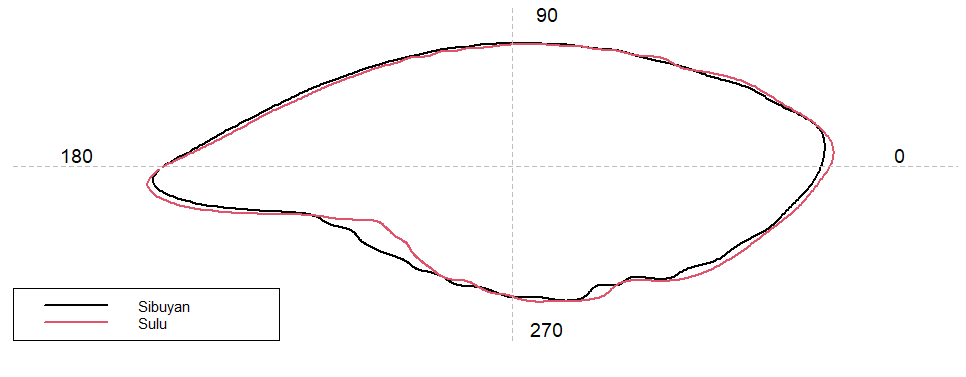
Figure 6. Mean right otolith shapes of D. kurroides collected from the Sibuyan Sea and Sulu Sea, Philippines.